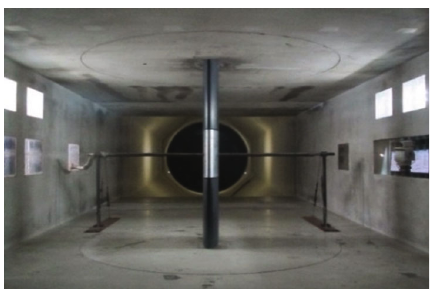
Figure 2: DBLN-526 model in wind